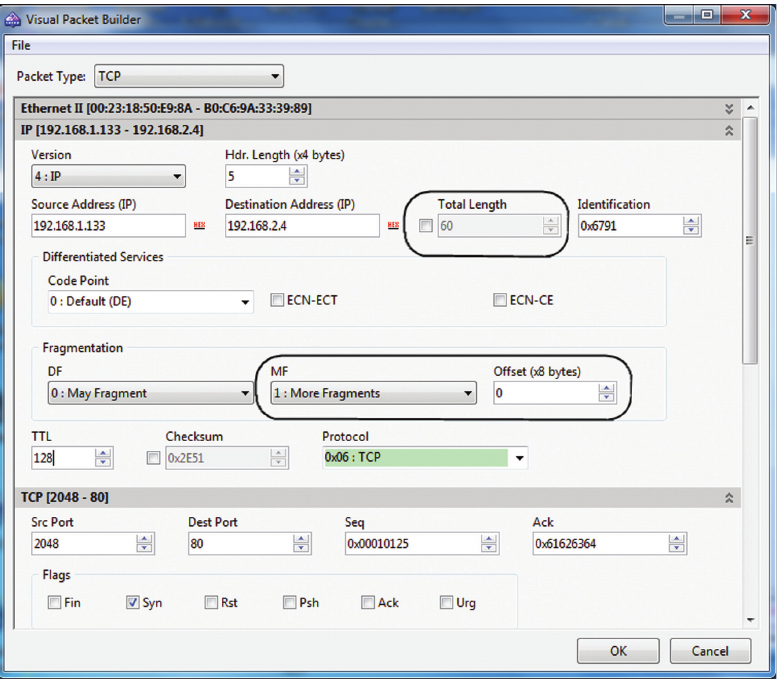
Figure 8. The First Fragment Packet of a Teardrop Attack.